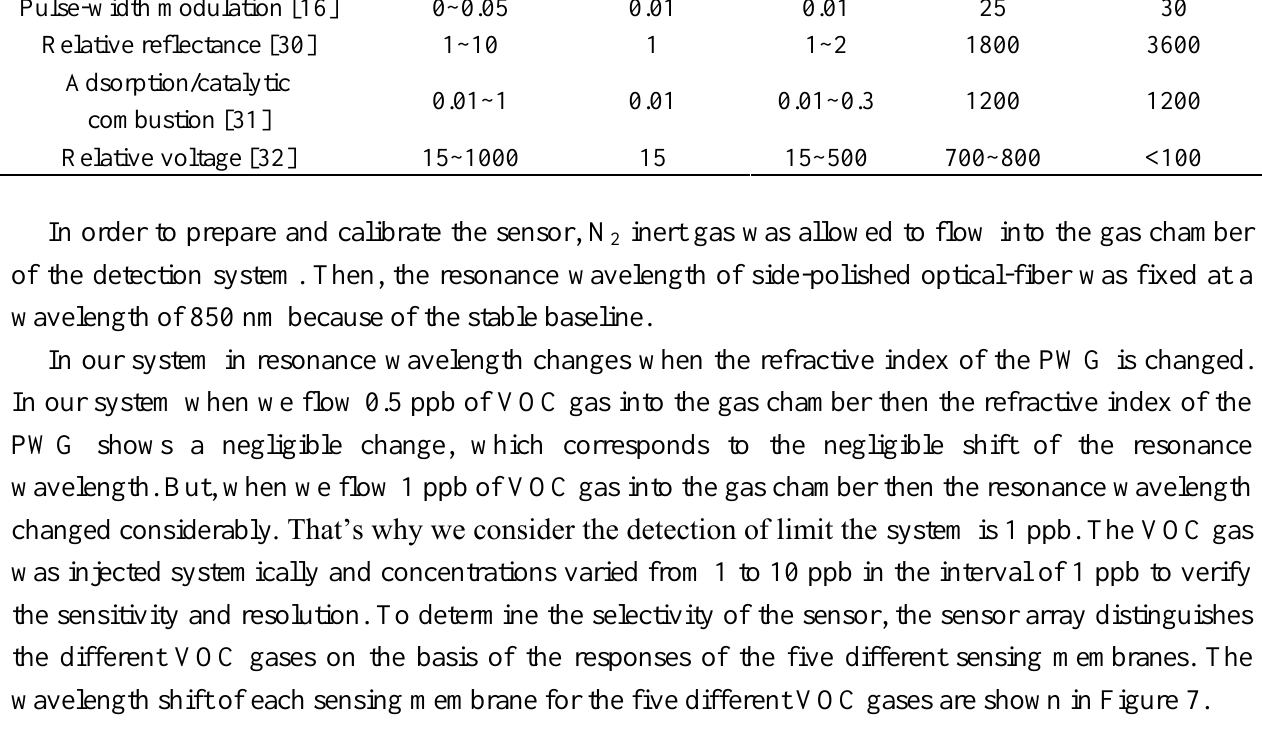
Figure 7. The resonance spectrum shift and second-regression of sensing membrane according to volatile organic compound gas concentration: ( a ) ethanol; ( b ) toluene; ( c ) dimethyalmine; ( d ) acetic acid; and ( e )